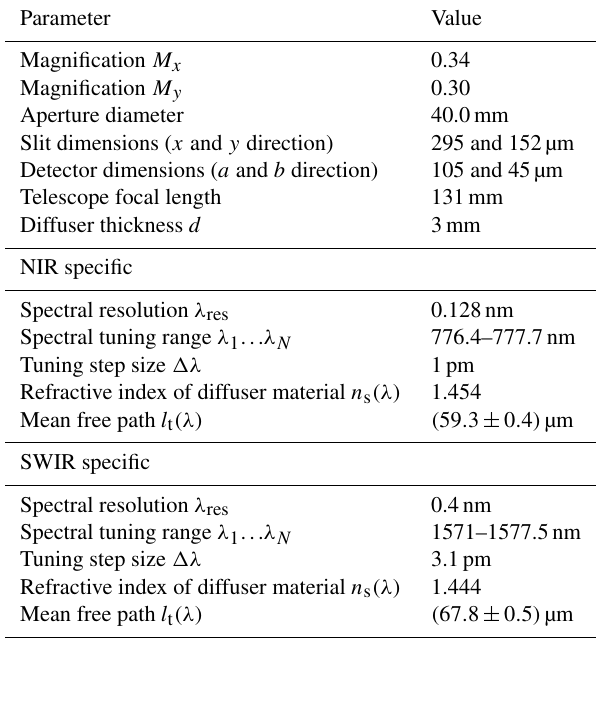
Table 1. Sample spectrometer parameters used for the measure- ment and prediction. They were chosen to represent a proposed in- strument for the European Space Agency’s CO2M mission (Meijer et al.,